Question: How would you classify this visualization?
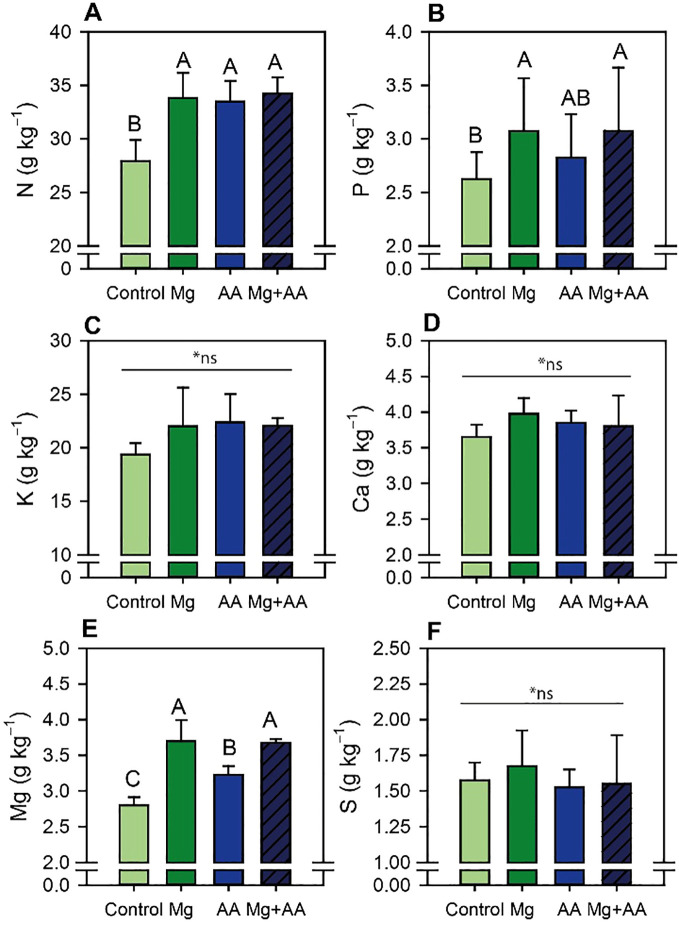
Answer: bar